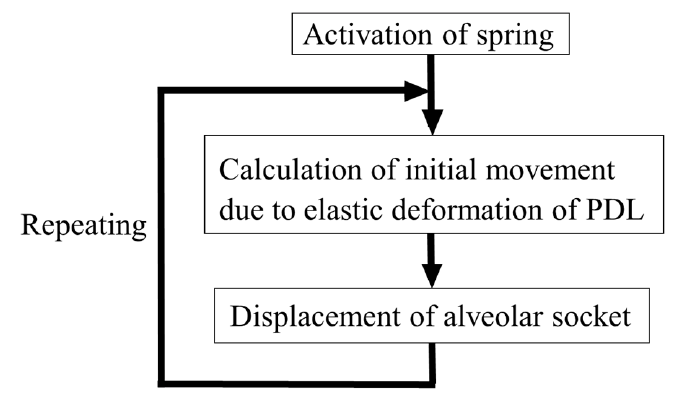
Figure 2. Procedure for simulating orthodontic tooth